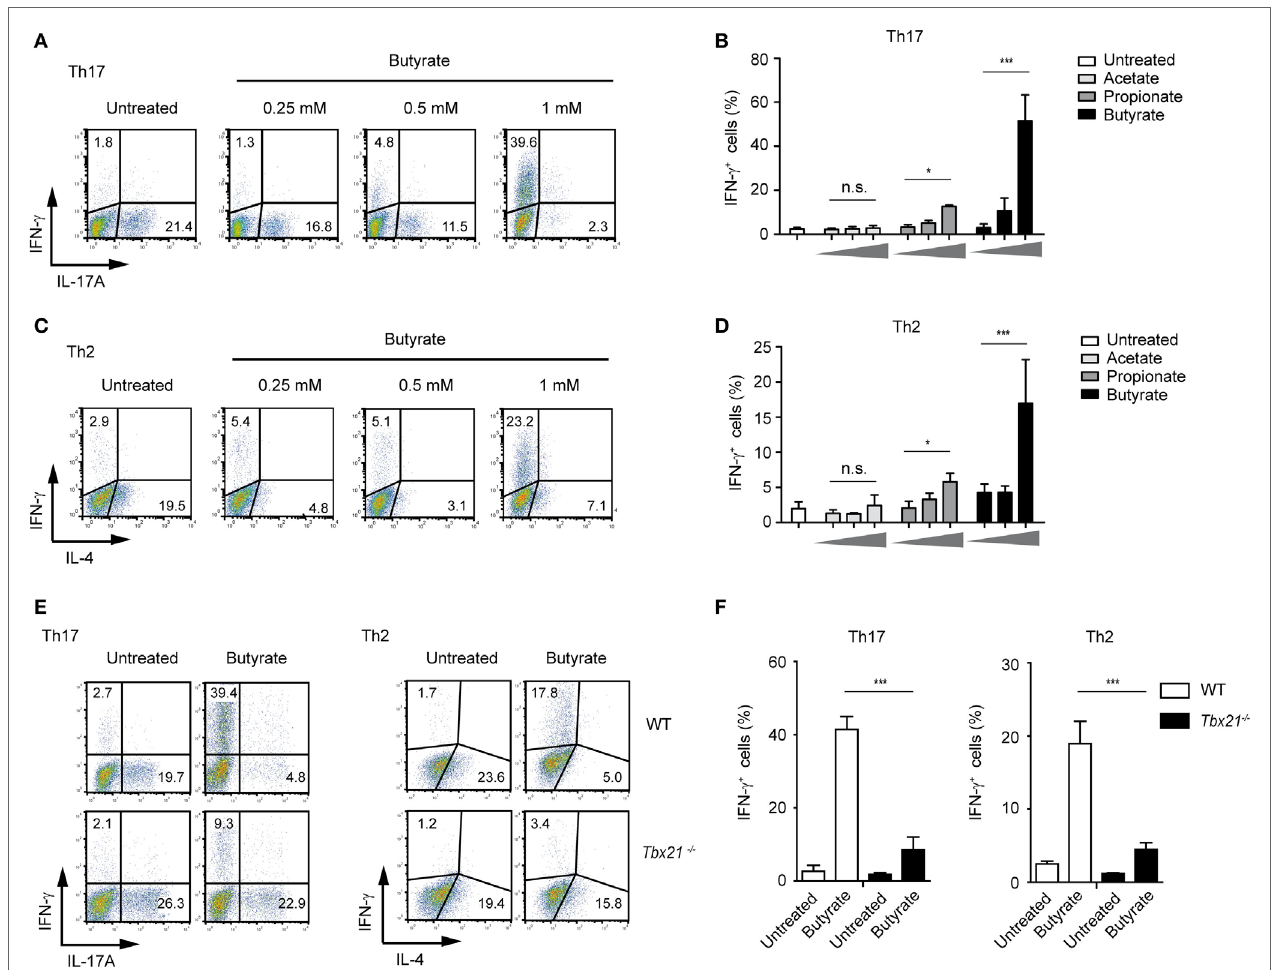
FigUre 5 | Impact of butyrate on Th17 and Th2 cells. (a–D) FACS analysis showing IFN- γ and IL-17A expression in CD4 + T cells cultured under Th17 conditions (a,B) or IFN- γ and IL-4 expression under Th2-polarizing conditions (c,D) for 6 days in the presence of indicated butyrate concentrations. Results in (B,D) represent the mean ± SEM of two experiments; * P = 0.01–0.05, *** P < 0.001, and n.s., not significant. (e,F) CD4 + T cells isolated from LNs and spleens of wild-type (WT) and Tbx21 − / − mice were cultured under Th17- or Th2-polarizing conditions in the absence or presence of 1 mM butyrate. After 6 days of the cell culture, the FACS analysis for IFN- γ and IL-17A (Th17 cells) or IFN- γ and IL-4 (Th2 cells) was performed. Data (F) are displayed as the mean ± SEM obtained from two independent experiments; *** P <